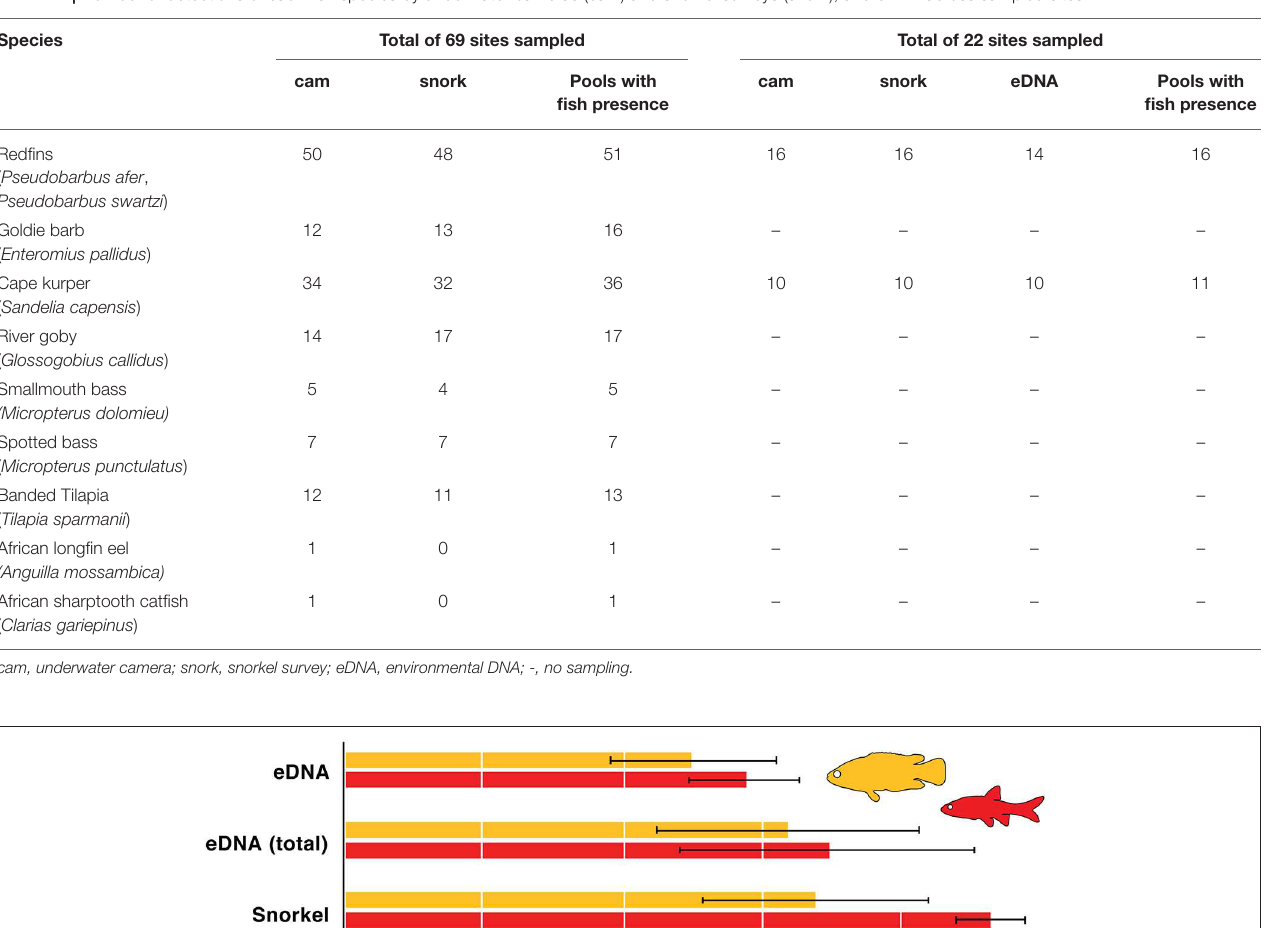
an insufficient number of detections of the other fish species across the sampling area. Across the 69 sampling sites, the model-averaged detection probability estimates for the redfins was 0.96 (SD = 0.03) using underwater cameras, and 0.93 (SD = 0.05) using snorkel surveys, 0.70 (SD = 0.21) for combined-replicate eDNA, and 0.58 (SD = 0.08) for eDNA replicates ( Figure 3 ). For Cape Kurper, the model-averaged estimates of the detection probability were 0.75 (SD = 0.15) using underwater cameras, 0.67 (SD = 0.16) for snorkel surveys, 0.64 (SD = 0.19) for combined-replicate eDNA, and 0.50 (SD = 0.12) for eDNA replicates ( Figure 3 ). For both fishes, eDNA consistently underperformed while underwater cameras had